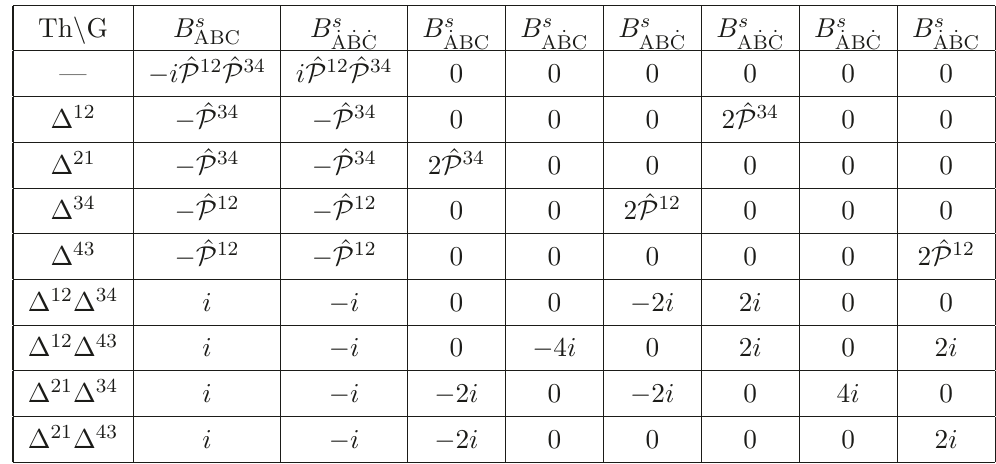
Table 1 . Threshold decomposition of the double